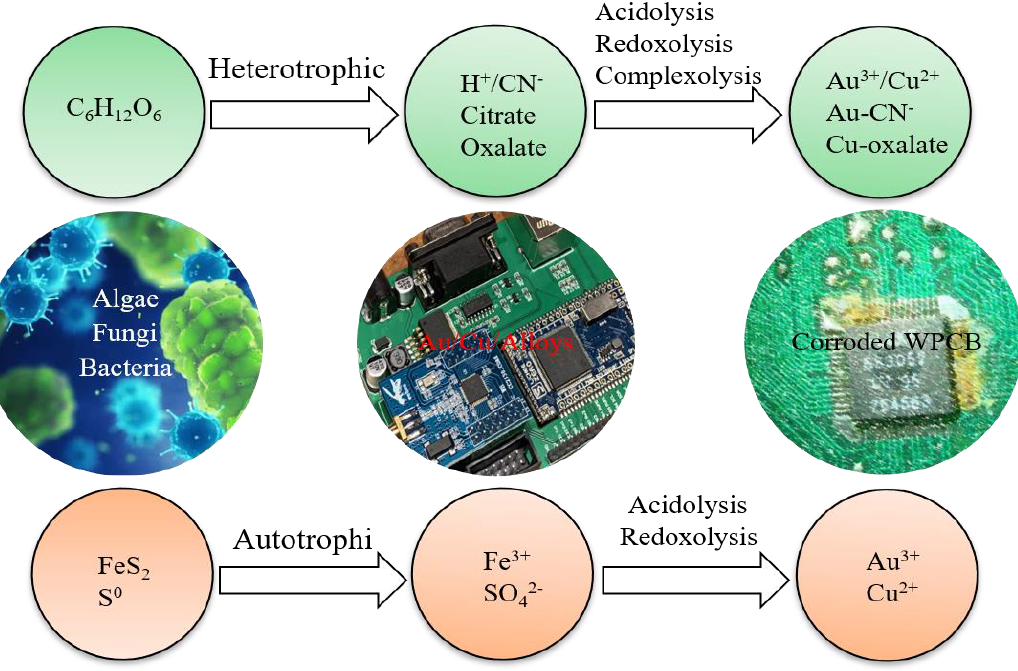
Figure 3. Heterotrophic and autotrophic bioleaching of WPCBs [26].